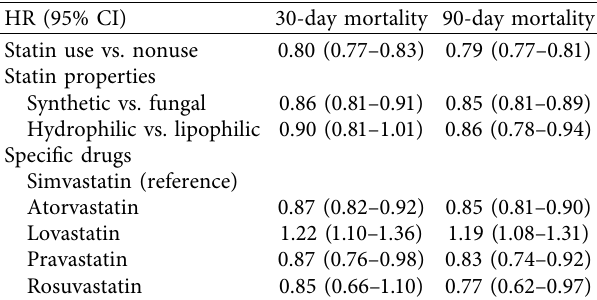
Table 3: Mortality risk comparison of statin use vs. nonuse of statins by biochemical property and of statins head-to-head. HR (95%